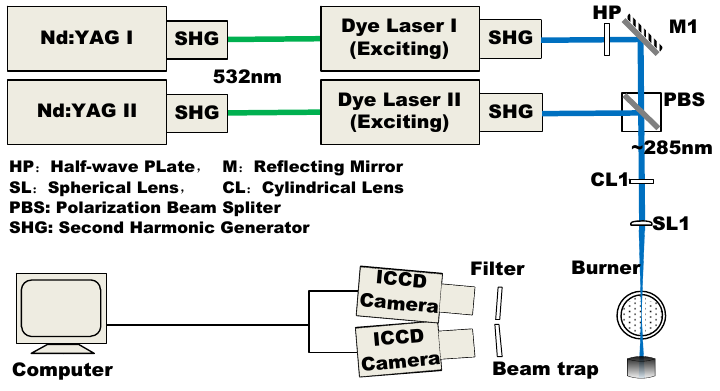
Figure 2. Diagram of two-color PLIF temperature measurement. To achieve thermometry calibration and comparison of temperature results, a N 2 - CARS system is used. The typical CARS experimental facility in the calibrated combustion furnace is shown in Figure 3. The thermometry uncertainty of CARS is better than 3% in the range of 1100–2100 K [23].